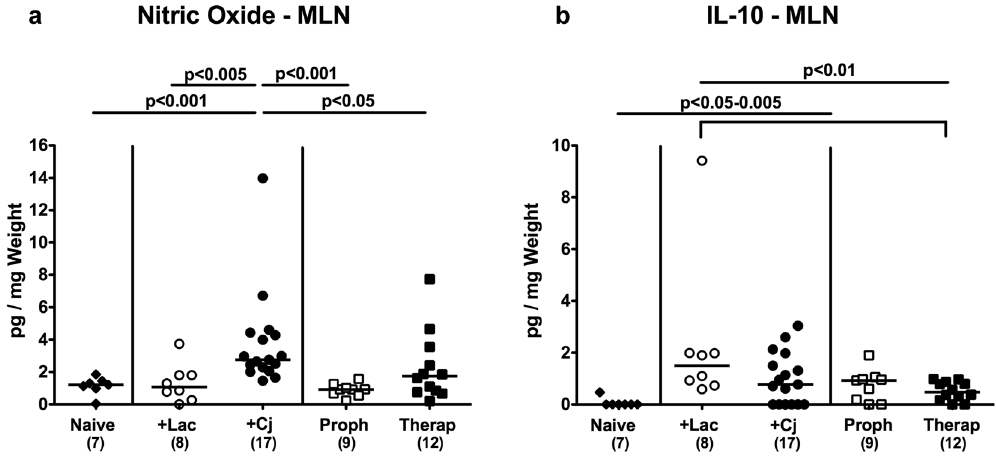
Figure 5. Secretion of pro- and anti-inflammatory mediators in mesenteric lymph nodes of C . jejuni strain 81–176 and/or L . johnsonii reassociated secondary abiotic mice. Secondary abiotic mice were perorally infected with C . jejuni strain 81–176 (Cj) and associated with L . johnsonii (Lac) either 14 days before (prophylactic regimen, Proph; white squares) or 7 days thereafter (therapeutic regimen, Therap; black squares) and compared to mono-associated mice ( + Lac, white circles; + Cj, black circles). ( a ) Nitric oxide and ( b ) IL-10 concentrations were determined in ex vivo biopsies derived from mesenteric lymph nodes (MLN) at days 21 or 28 following initial C . jejuni or L . johnsonii infection, respectively. Naive (N) mice (black diamonds) served as uninfected controls. Medians (black bars), level of significance (p-value) determined by one-way ANOVA test followed by Tukey post-correction test for multiple comparisons and numbers of analyzed animals (in parentheses) are indicated. Data were pooled from three independent